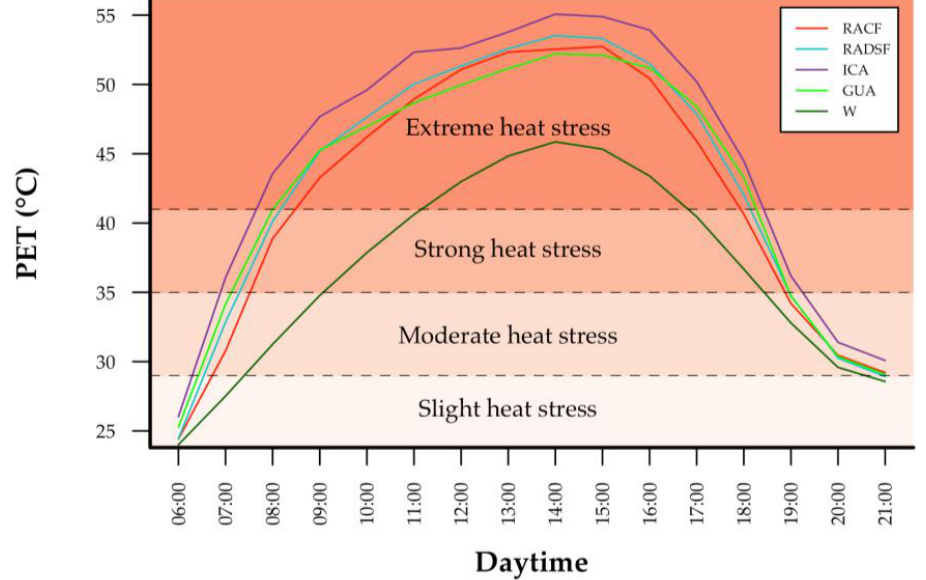
Figure 5. Mean Envi-met modeled PET daytime trends for the main test area land cover classes. (RACF = residential areas with continuous fabric; RADSF = residential areas with discontinuous and sparse fabric; ICA = industrial and commercial areas; GUA = Green Urban Areas; W = woodland;). Background colors indicate the grade of physiological stress based on PET ranges for Western/Middle Europe (internal heat production: 80 W, heat transfer resistance of the clothing: 0.9 clo) according to Matzarakis et al. [28].